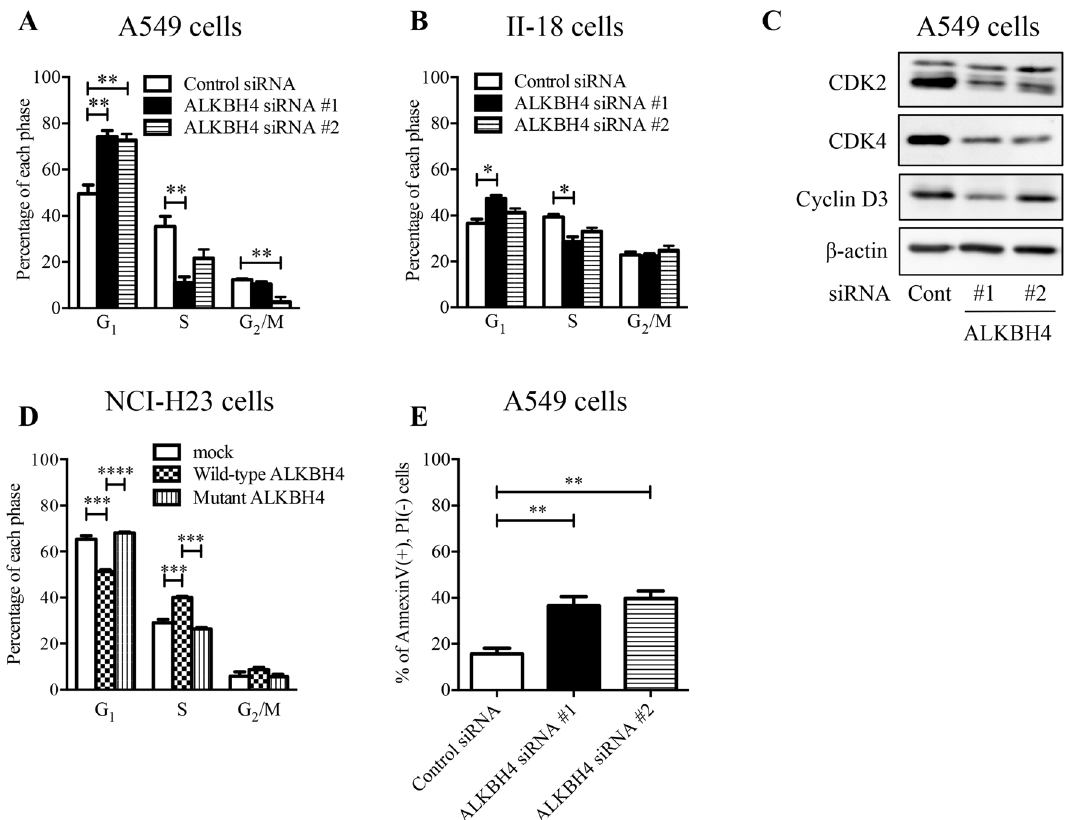
Figure 3. ALKBH4 knockdown induced G1 phase arrest in NSCLC cells. A549 cells ( A ) or II-18 cells ( B ) were transfected with ALKBH4 siRNAs or control siRNA for 48 h and the cell cycle was analysed using a flow cytometer. Values are represented as means ± S.D. of three independent experiments. *p < 0.05; **p < 0.01 vs. control siRNA (One-way ANOVA with Bonferroni post-hoc tests). ( C ) Lysates of A549 cells transfected with ALKBH4 siRNAs or control siRNA were subjected to Western blot analysis with anti-CDK2, anti-CDK4, anti- Cyclin D3, and anti-β-actin antibodies. Uncropped Western blot data are shown in Supplementary Fig. S9. Representative pictures of three independent experiments are shown. ( D ) NCI-H23 cells were transfected with wild-type ALKBH4 or mutant ALKBH4 for 48 h and the cell cycle was analysed using a flow cytometer. Values are represented as means ± S.D. of three independent experiments. ***p < 0.001; ****p < 0.0001 (One- way ANOVA with Bonferroni post-hoc tests). ( E ) A549 cells were transfected with ALKBH4 siRNAs or control siRNA for 48 h and the apoptosis was analysed using a flow cytometer. Values are represented as means ± S.D. of three independent experiments. **p < 0.01 vs. control siRNA (One-way ANOVA with Bonferroni post-hoc